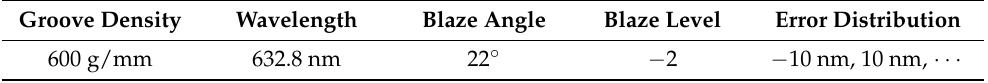
Figure 2. Conditions for the maximum value of grating diffraction. Equation (11) is applied to solve the diffraction spectrum distribution of the ideal grating. The grating parameters are shown in Table 1. Table 1. Diffraction grating parameters. Groove Density Wavelength